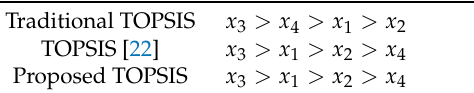
Table 15. Results comparison.